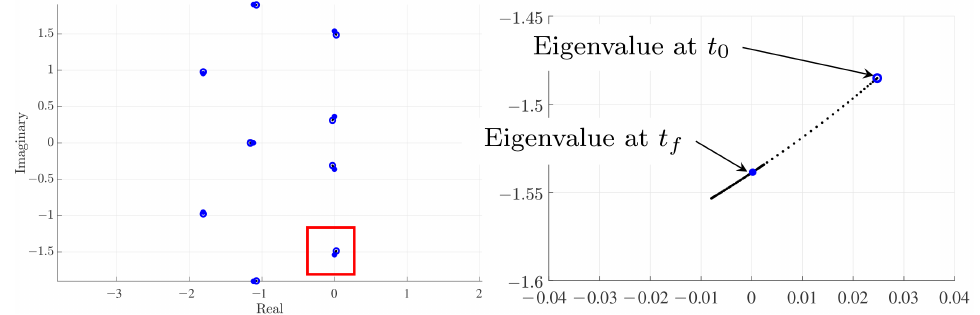
Figure 4. Eigenvalue repartition for the first